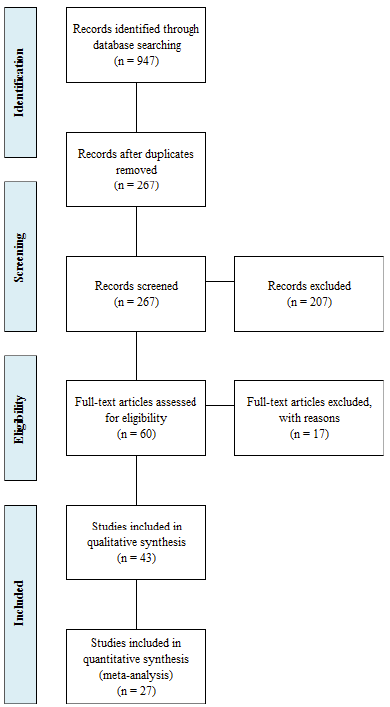
Figure 1. PRISMA flow